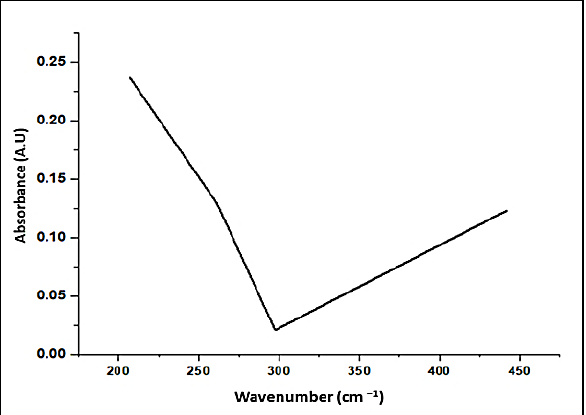
Table 2. UV-visible spectrum of methanolic extract of A. platensis nanoparticles. Peak No.